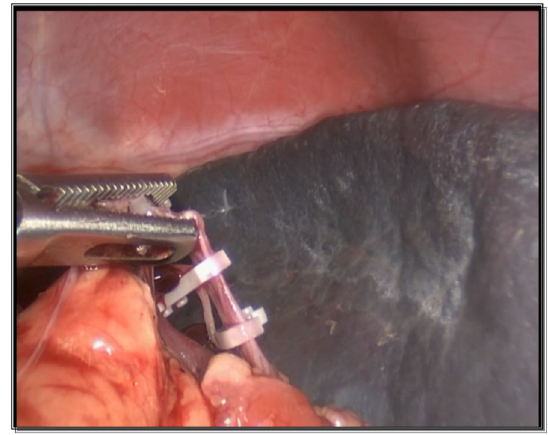
Fig. 6 Control of the vein with Hem-o-lock clips